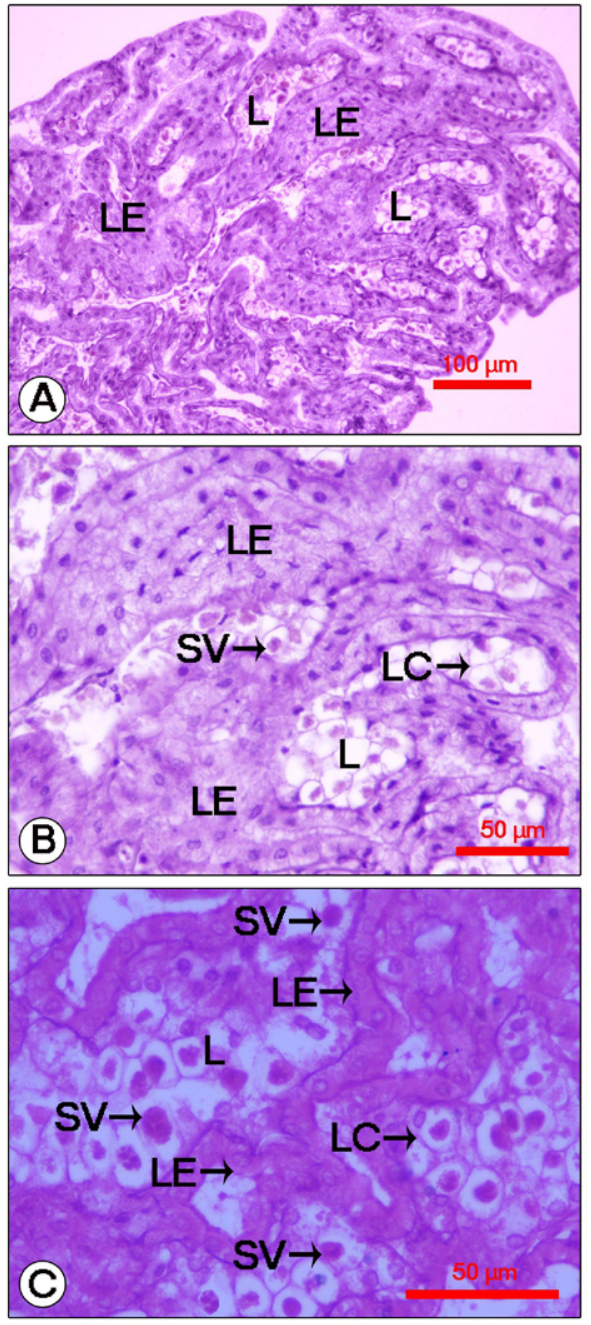
Figure 8. Light micrograph of histological sections of Y-organ of crabs treated with MF during C4 stage in Travancoriana schirnerae. ( A ) Compactly packed lobules without inter-lobular spaces. ( B ) Lobules with multilayered epithelium. ( C ) Larger cells enclosing secretory vesicles. L: Lobule; LC: Larger cell; LE: Lobular epithelium; SV: Secretory